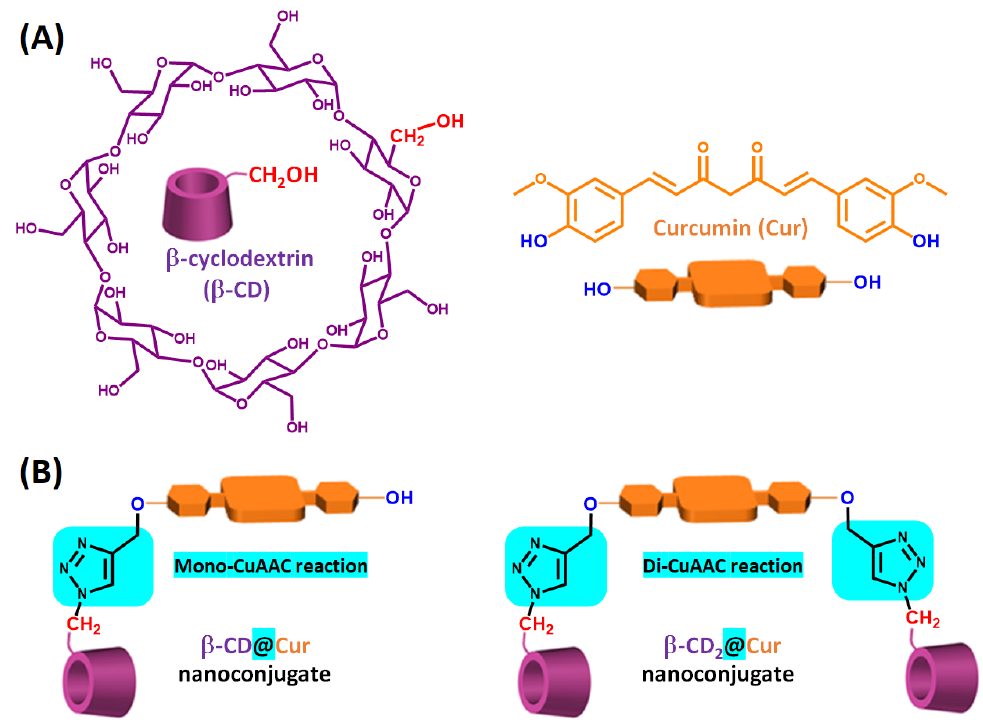
Figure 1. ( A ) Chemical structures of β-CD and Cur, and ( B ) schematic illustration of β-CD@Cur and (β-CD) 2 @Cur nanoconjugates obtained through mono- and di-CuAAC reaction.